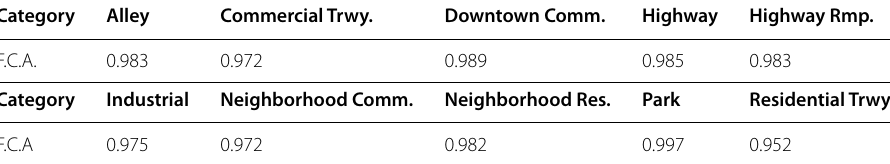
Table 2 Fraction of correctly assigned (F.C.A.) images for each category in the training set A T Category Alley Commercial Trwy. Downtown Comm. Highway Highway Rmp.